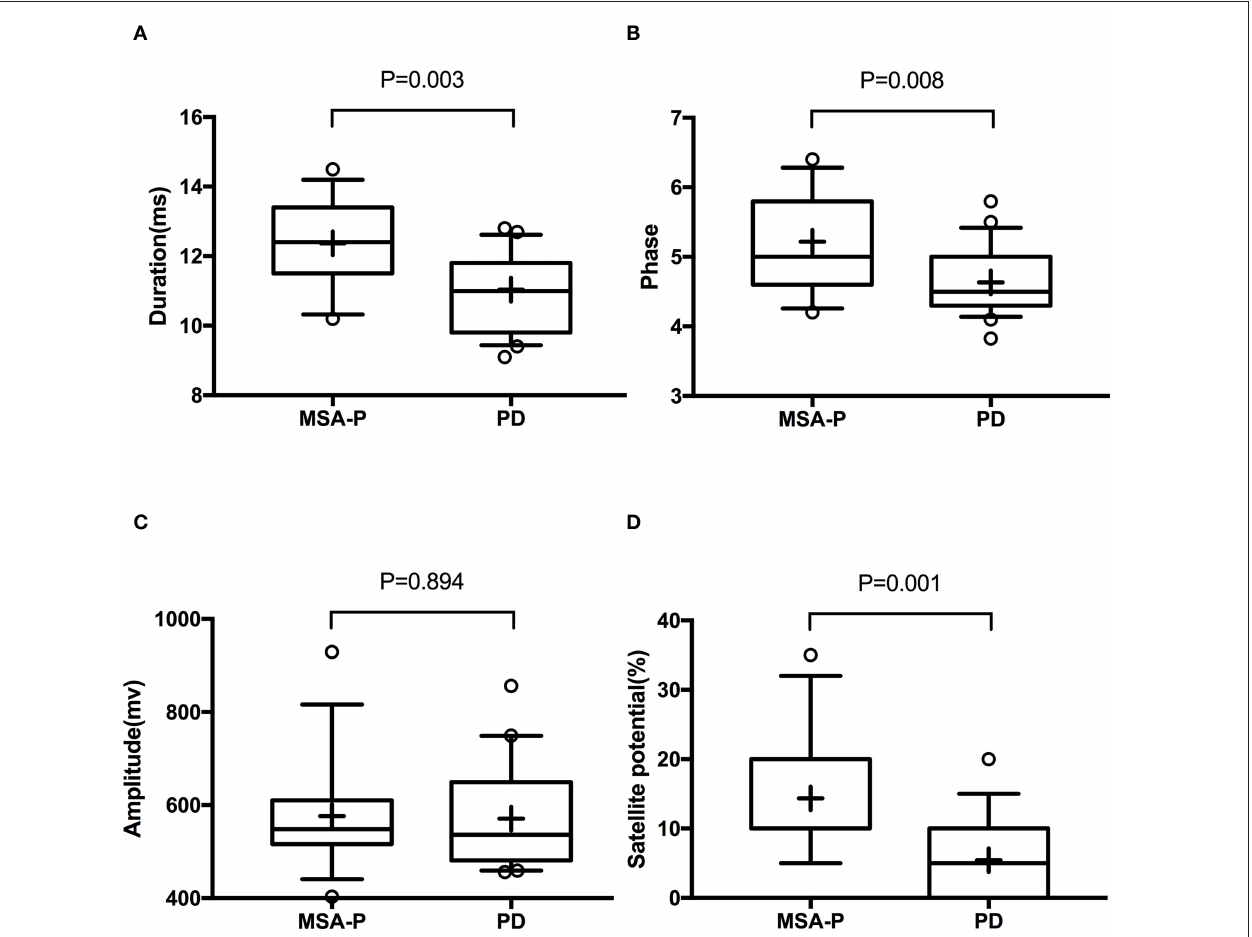
FIGURE 2 | Box plot of duration (A) , phase (B) , amplitude (C) , and satellite potential (D) between MSA-P and PD. This box plot depicted the median and quartiles. “ + ” represent the mean value.